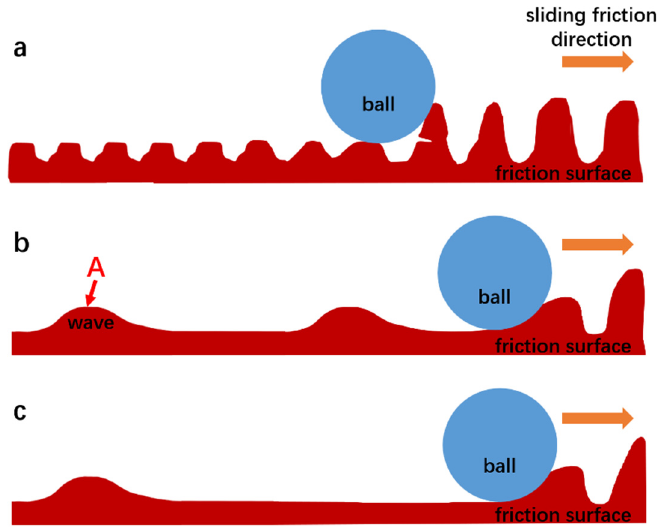
Figure 10. ( a ) Schematic diagram of the change of the wear surface morphology during the friction and wear process at room temperature; ( b ) Schematic diagram of the formation of wavy folds on the wear surface when the temperature of the friction and wear test increased; ( c ) The temperature of the friction and wear test was further increased; the spacing of the wavy folds on the wear surface increases.